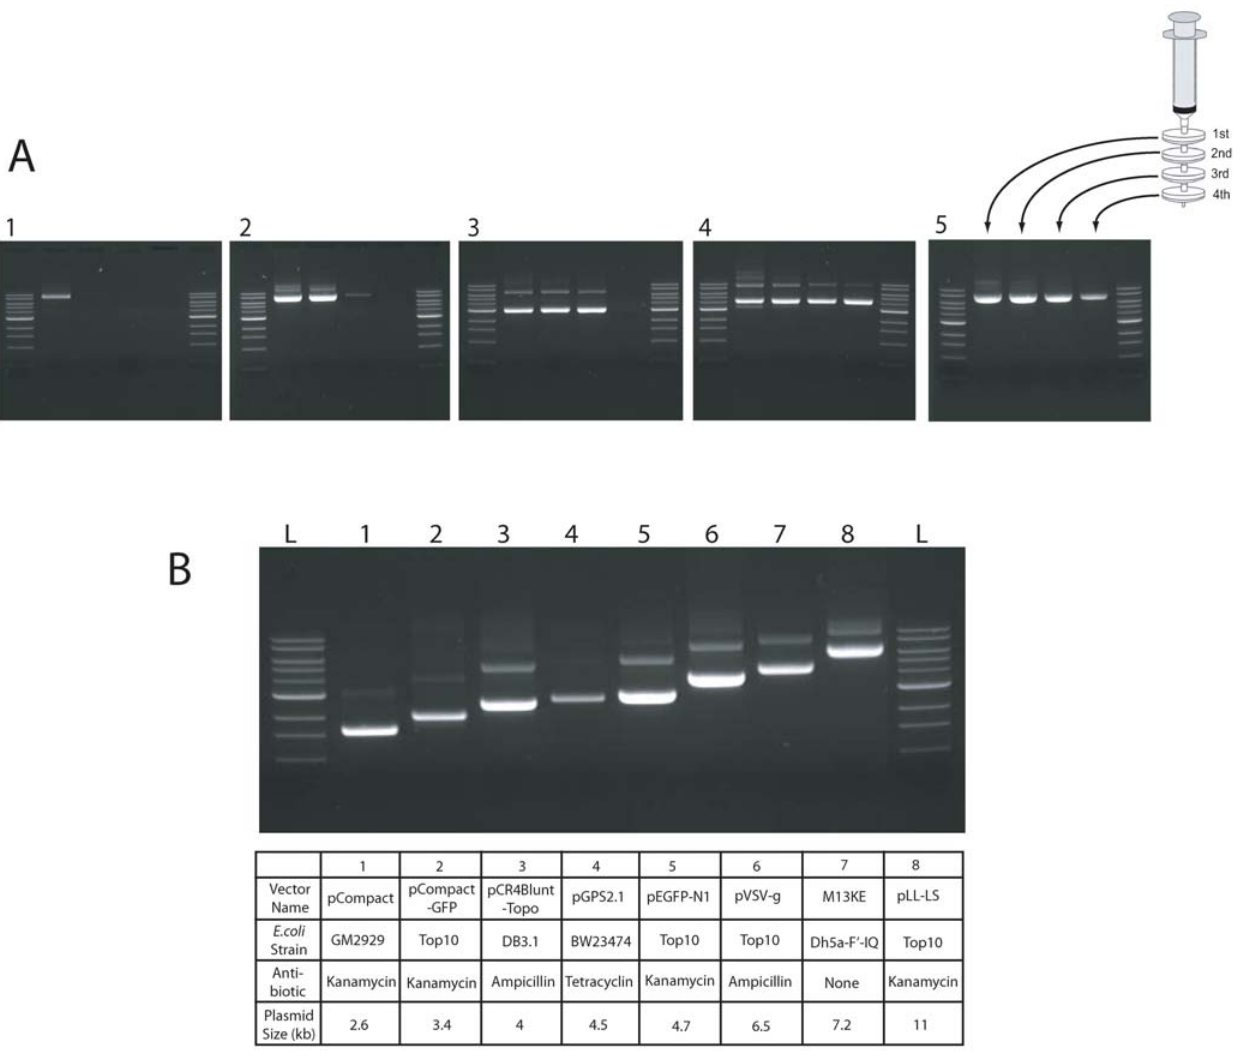
Figure 2. Plasmid purification from cells having different copy number plasmids with different sizes. (A) Four plasmids having a different copy number in E. coli were used for plasmid purification. All E. coli were cultured in 50 ml of LB for 18 hours at 37 u C, lysates prepared as described, and plasmid purified with 4 consecutive glass syringe filters. Each plasmid bearing glass syringe filter was eluted with 1 ml TE and 5 ul was loaded on a 0.8% TAE agarose gel. 1: pMD2.GY, 2: pLL-LS, 3: pCompact-GFP, 4: pVSV.G, 5:500 ml of E.coli bearing low copy number plasmid, pMD2.GY. A 1 kb ladder marker (NEB) is shown in the outside lanes of each gel. (B) E.coli bearing different plasmids were cultured in 50 ml LB and the plasmid purified from cell lysates using 4 glass syringe filters. The isolated plasmids were resuspended in 1 ml TE (pH 8.0) and 2 ul was loaded on to a 0.8% TAE agarose gel. L: 1 kb ladder (NEB).